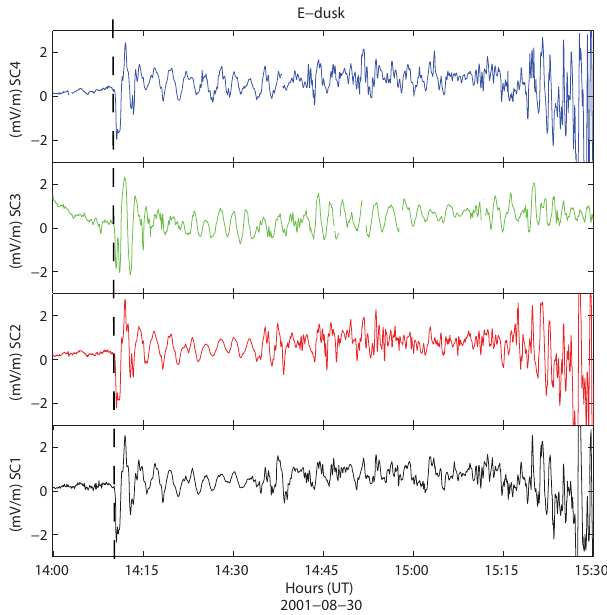
Fig. 4. Duskward electric field for for SC 1 (black), SC 2 (red), SC 3 (green) and SC 4